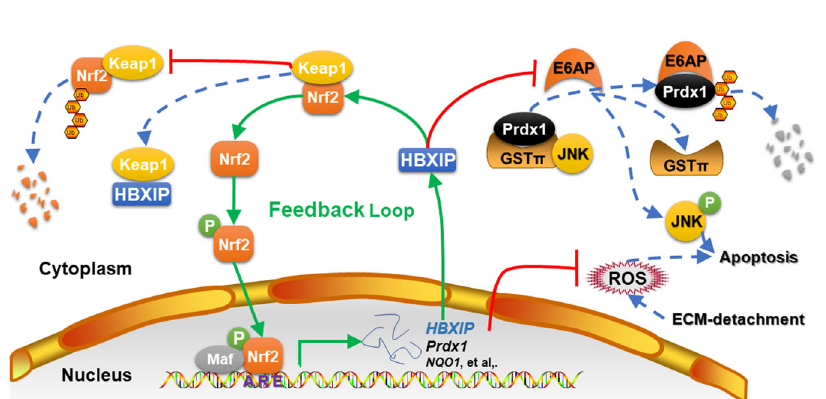
Fig. 6 The HBXIP/Nrf2 feedback loop induces metastasis and anoikis resistance in breast cancer cells in vivo. A At 4 days after the i.p. injection with stable HBXIP/Nrf2 KD MDA-MB-436 cells and stable Prdx1 OE HBXIP/Nrf2-de fi cient MDA-MB-436 cells, the viable cells were counted using the trypan blue exclusion assay after removing possible contaminating mouse cells. B Representative images of lung tissue and tissue sections from the indicated groups of mice were obtained 3 weeks after the tail vein injection of the indicated stable breast cancer cells. Scale bars, 200 μ m. C The lung metastatic nodules in the mouse lungs shown in B were counted. D The expression of the HBXIP and Prdx1 proteins in normal breast tissues, primary breast cancer tissues, and metastatic lymph node tissues were examined using IHC. Scale bars, 50 μ m. E The association between HBXIP and Prdx1 expression levels in the abovementioned IHC assay was statistically analyzed by χ 2 test. F Heatmap of HBXIP and Prdx1 expression in the tumor tissues from each patient referenced in D . G Correlations between HBXIP and Prdx1 expression in patients with breast cancer are referenced in panel F . H Expression levels of the HBXIP and Prdx1 mRNAs ( z scores, RNA Seq V2 RSEM) were analyzed in 994 clinical breast cancer samples (Pearson ’ s correlation coef fi cient; r = 0.43, Spearman ’ s correlation coef fi cient = 0.47). I The patients with breast cancer referenced in H were fi ltered into four groups (Prdx1 high = 359, HBXIP high = 354, HBXIP high/Prdx1 high = 215, HBXIP high/Prdx1 low = 139) according to the HBXIP and Prdx1 expression levels and z scores. An overall survival curve was generated using the Kaplan – Meier method, and results were statistically compared using a log-rank test. p values were determined using Student ’ s t test for the data shown in ( A , C , and G ) and using a chi-square test for the data in E .